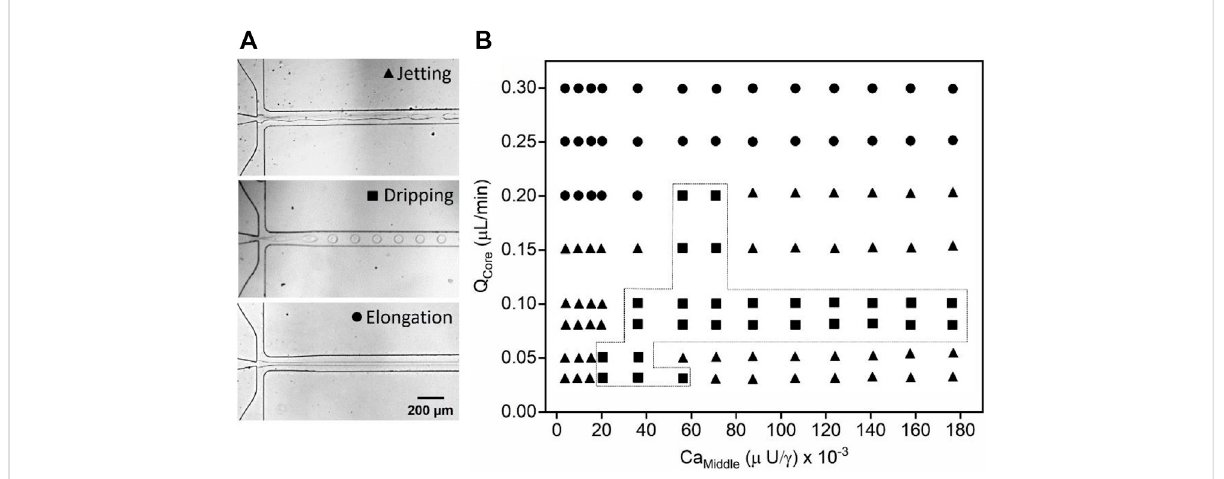
FIGURE 2 W/w droplet generation in the micro fl uidic device. (A) Optical microscope images of the different fl ow regimes observed during the droplet generation at the fl ow-focusing junction, and (B) phase diagram plotted as a function of the Q Core and capillary number (based on Q Middle ) (Ca Middle ) showing different fl ow regimes such as jetting, dripping, and elongation. The pneumatic valve at a pressure of 0.35 MPa was used for all the